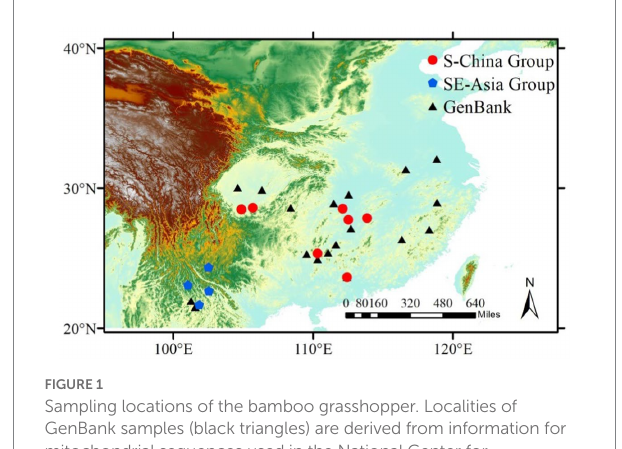
FIGURE 1 Sampling locations of the bamboo grasshopper. Localities of GenBank samples (black triangles) are derived from information for mitochondrial sequences used in the National Center for Biotechnology Information (NCBI) (Supplementary Table S2). S-China Group (red circles) represents samples obtained in this study and belonging to the cluster S-China Group in population structure (also see Figure 4). SE-Asia Group (blue pentagons) represents samples obtained in this study and belonging to the cluster SE-Asia Group in population